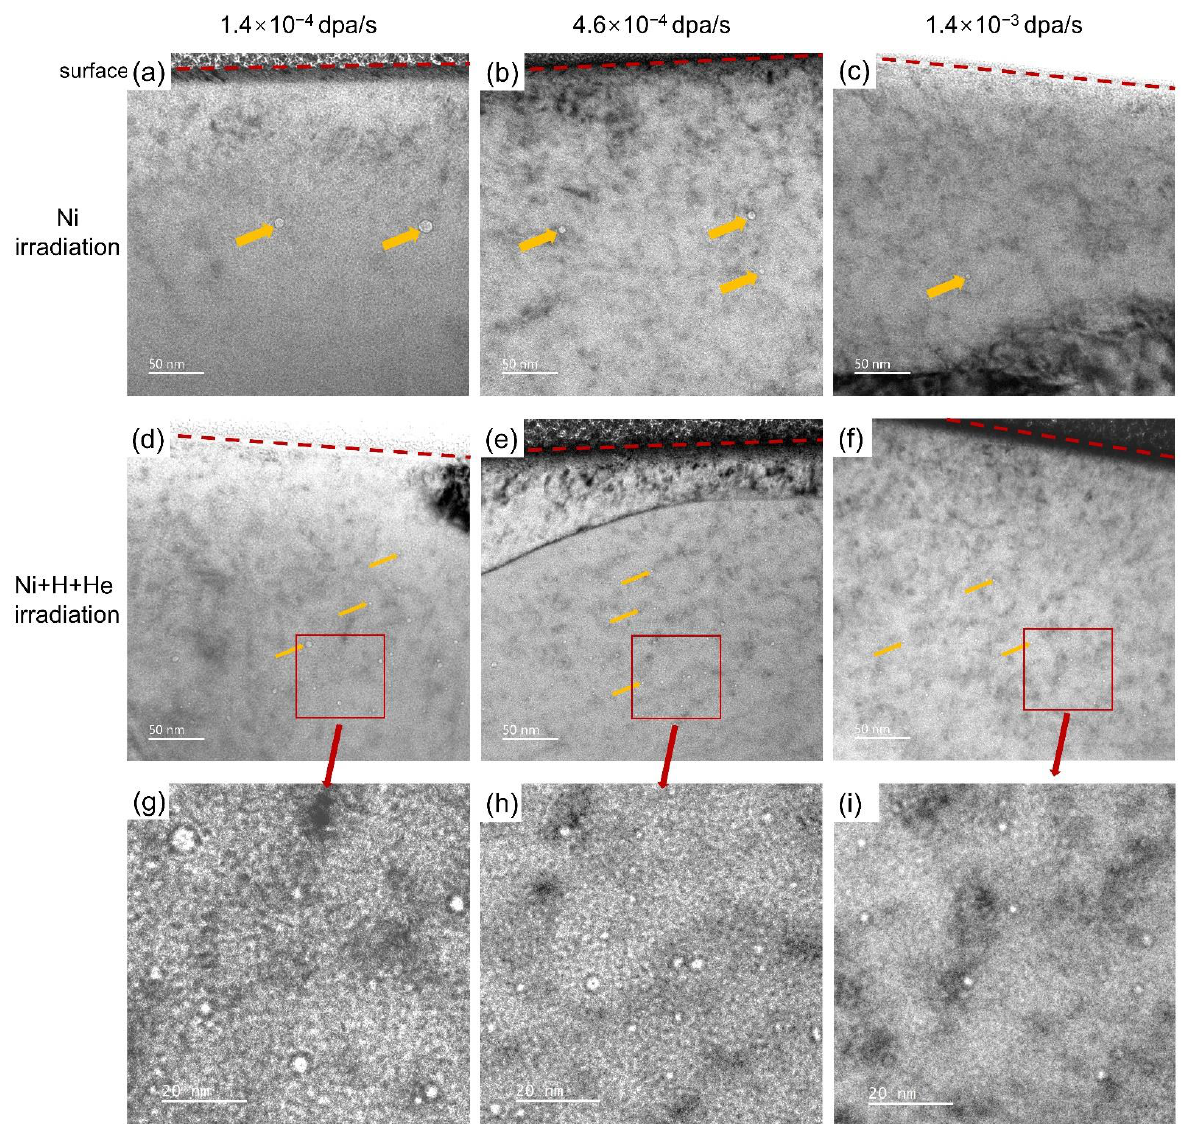
Figure 2. Bright field TEM images of cavities in pure nickel induced by ( a – c ) Ni + irradiation and ( d – f ) (Ni+H+He) triple ion irradiation at 450 °C to ~1 dpa. ( a , d ), ( b , e ), ( c , f ) correspond to the damage rate of 1.4 × 10 − 4 , 4.6 × 10 − 4 and 1.4 × 10 − 3 dpa/s, respectively. A few typical cavity examples are indicated by yellow arrows. The red dashed lines indicate the specimen surface. ( g – i ) are local zoomed images of the red boxed areas in ( d – f ), as indicated by the